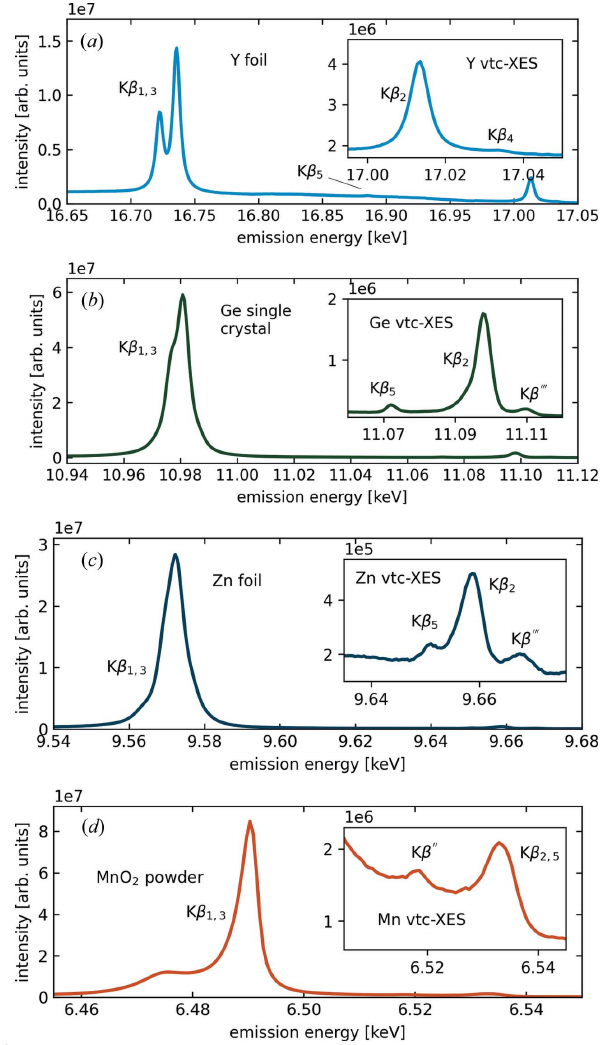
Figure 3 Examples of non-resonant K (cid:6) XES spectra. The insets show the valence- to-core (vtc) regions of the respective spectra. ( a ) An yttrium K (cid:6) XES spectrum of an yttrium foil. ( b ) AGe K (cid:6) XES spectrum of a Ge foil. ( c ) A Zn K (cid:6) XES spectrum of a polycrystalline ZnO powder sample. ( d ) A Mn K (cid:6) XES spectrum of a polycrystalline MnO powder